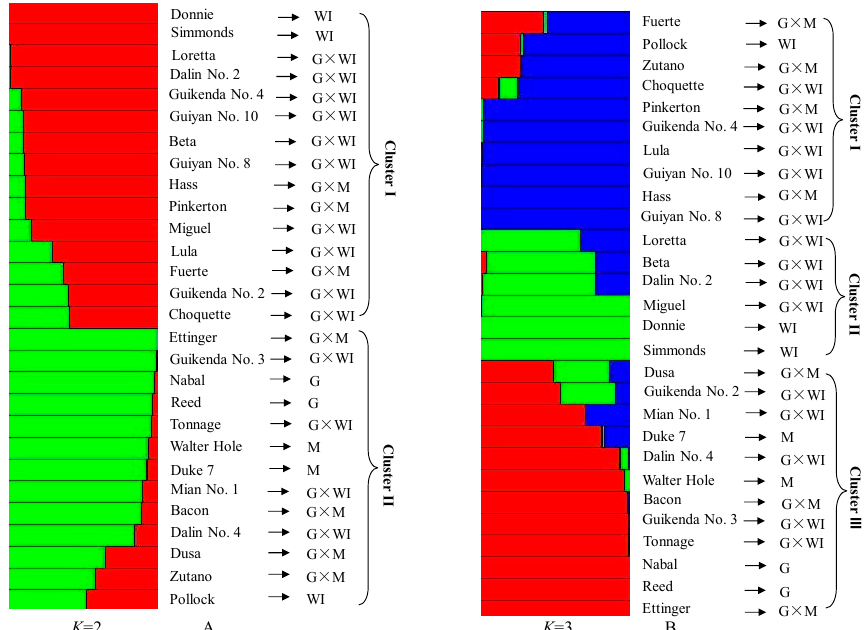
Figure 4. Population structure of avocado. ( A ) Population structure analysis of 28 avocado accessions under number of populations ( K = 2) based on 16 polymorphic EST-SSRs from transcriptome data using STRUCTURE, each individual is represented by a vertical bar. ( B ) Population structure analysis of 28 avocado accessions at K = 3 based on 16 polymorphic EST-SSRs from transcriptome data using STRUCTURE, each bar represents a single individual.